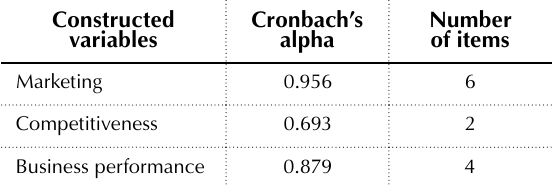
Table 1. Reliability testing using Cronbach’s alpha